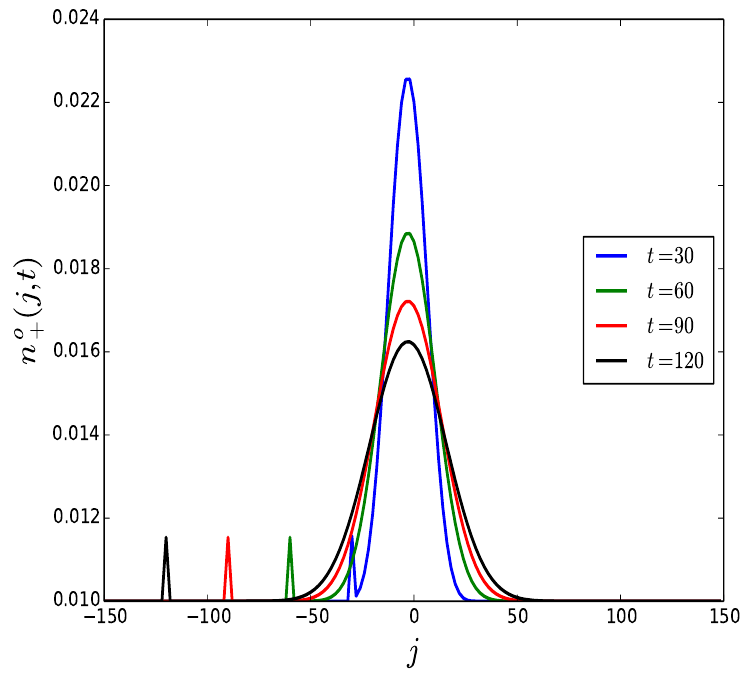
Figure 4: Time evolution of the density profile. The values of the parameters are ρ = 0.01, ρ = 0.25, λ = 0.3, λ = + − + −